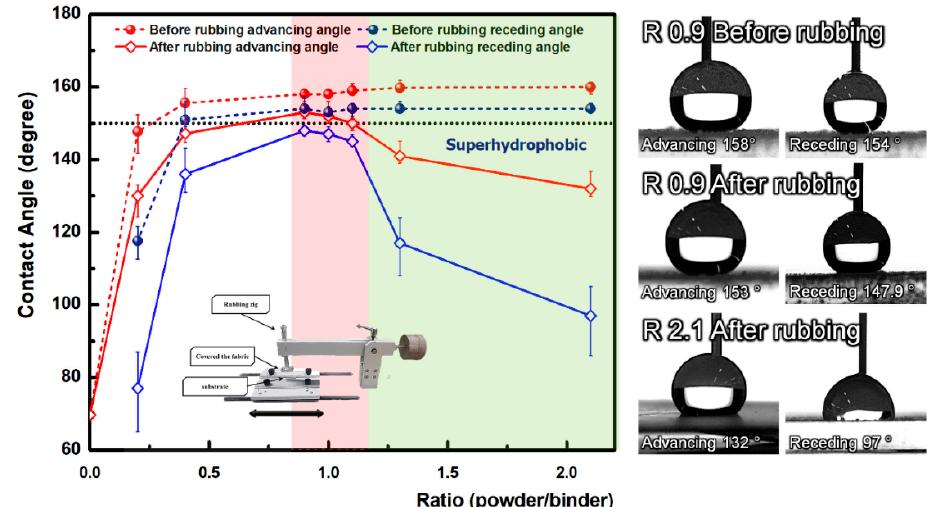
Figure 4. Advancing and receding contact angles with different particle weight ratio surfaces, before and after mechanical abrasion test.